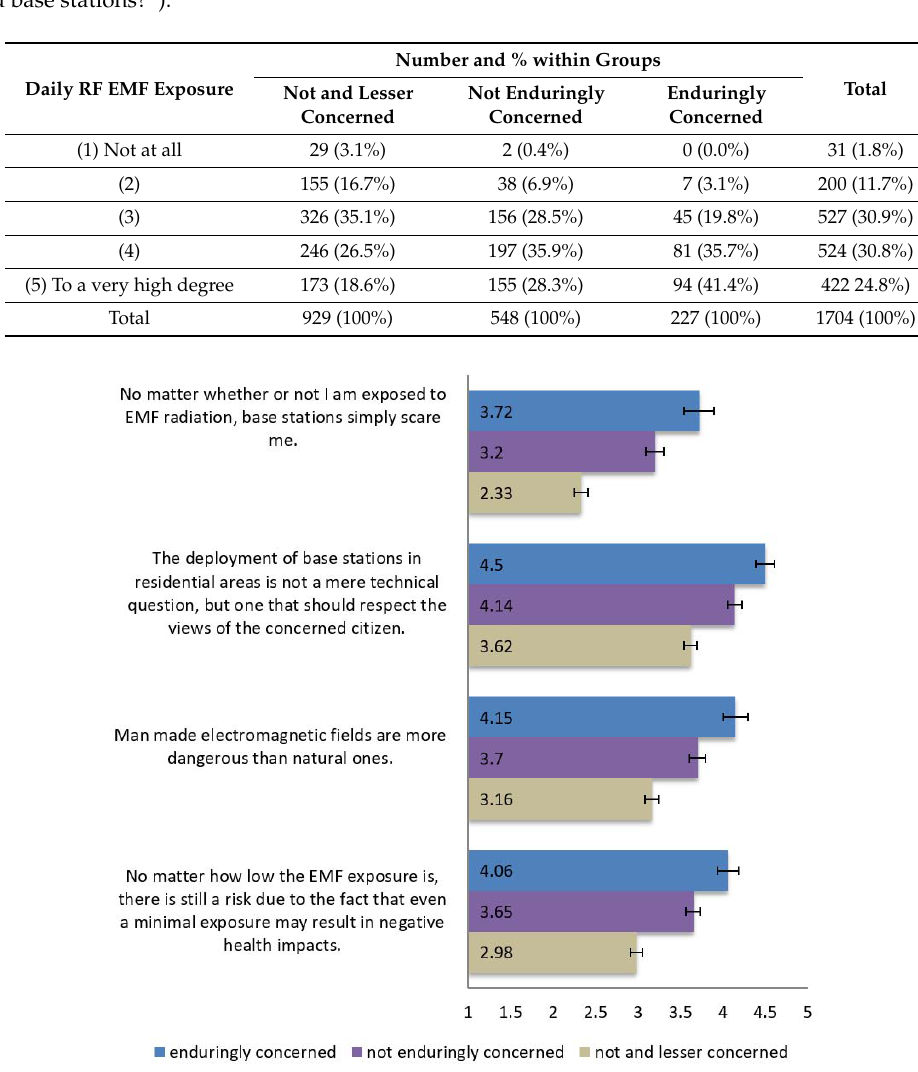
Figure 2. Beliefs about radio frequency electromagnetic field (RF EMF) exposure (Question: “Please tell us to what extent you agree with the following statements”; on a 5–point Likert scale from 1 = “Not at all” to 5 = “Absolutely”); statements and related means of the responses are indicated in the figure. Error bars indicate 95%